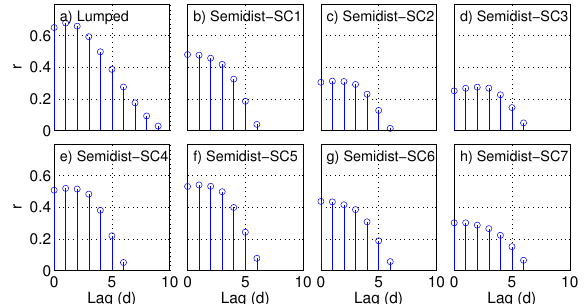
Figure 6. Lag-correlation coefficient ( r ) between the simulated streamflow at N7 (mmd − 1 ), and the daily rainfall (mmd − 1 ) of the entire catchment (a) and the seven sub-catchments (b) – (h) .